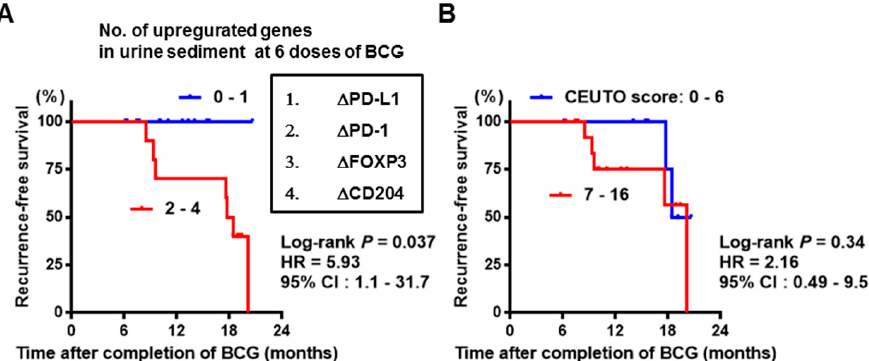
Figure 3. Intravesical recurrence-free survival curves. ( A ) Stratification according to the number of upregulated genes in urine sediment after intravesical BCG. The log-rank test was used for the comparison between 0–1 (n = 14) and 2–4 (n = 10). ( B ) Stratification according to the CUETO recurrence score. The log-rank test was used for the comparison between 0–6 (n = 9) and 7–16 (n = 15). HR, hazard ratio; CI, confidence interval. Table 4. The prognostic factors for recurrence in 24 patients treated with intravesical BCG.